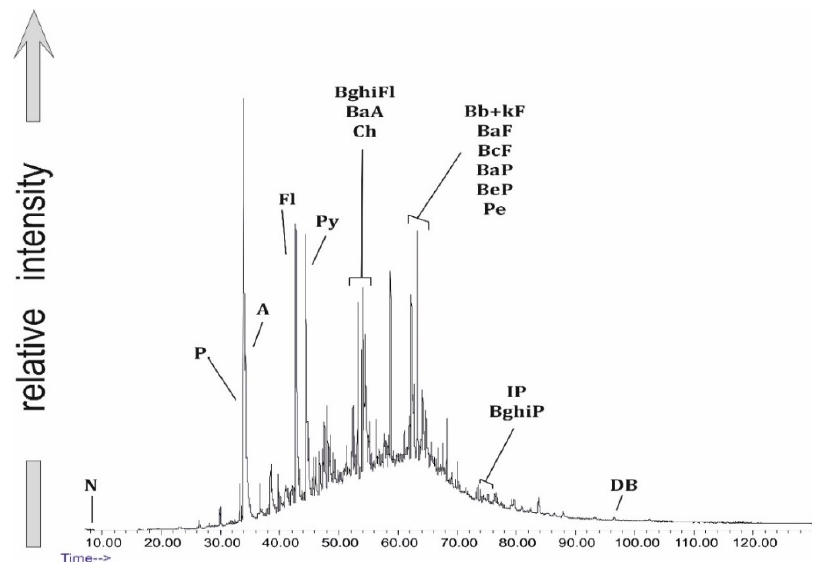
Figure 6. Generalized PAH distribution in sample WR12G.